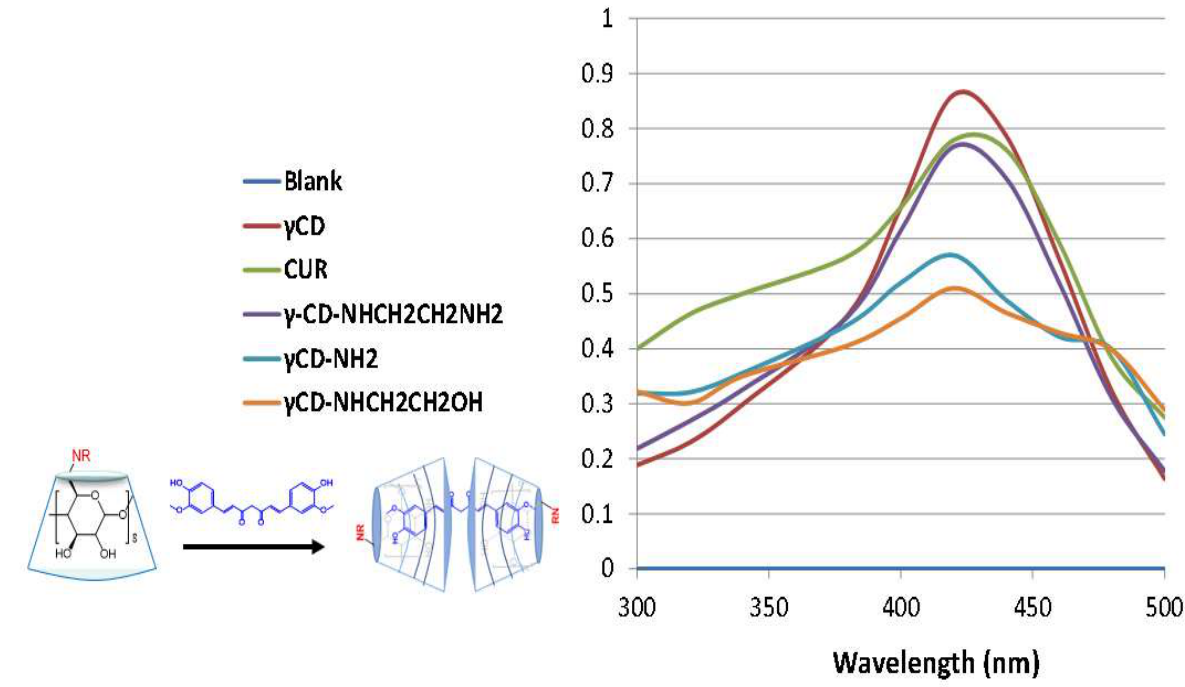
Figure 4. Absorption spectra of (0.04 mM) CUR, (0.34 mM), CUR-γ-CD-NH 2 , CUR-γ-CD- NHCH 2 CH 2 NH 2 , and CUR-γ-CD-NHCH 2 CH 2 OH.